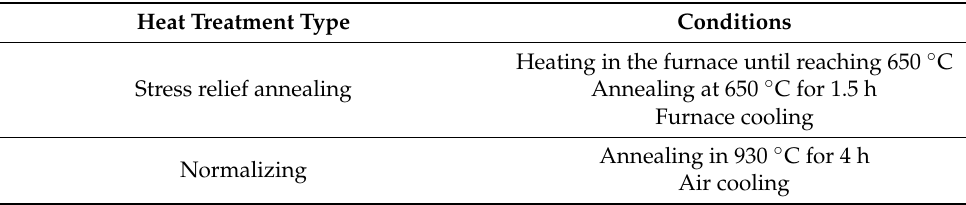
Table 3. 21NiCrMo2 steel heat treatment conditions